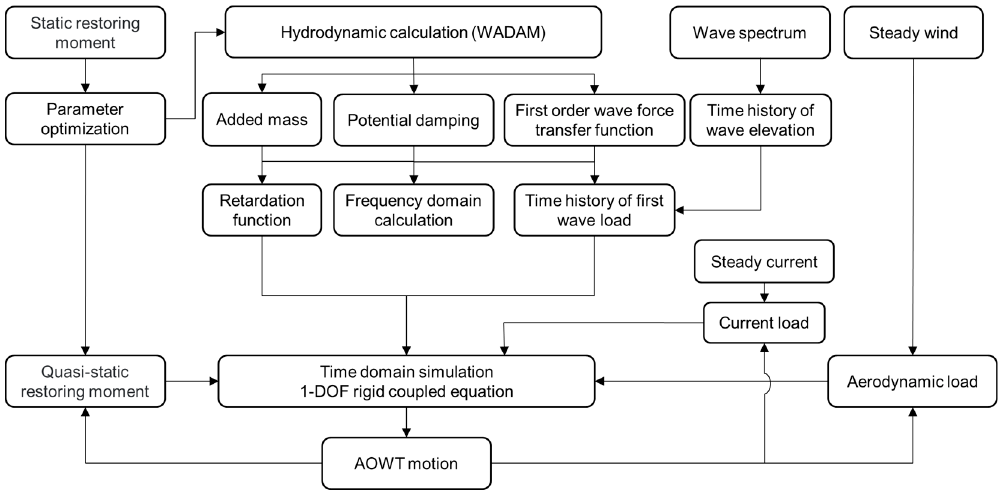
Figure 3. Flow Chart.